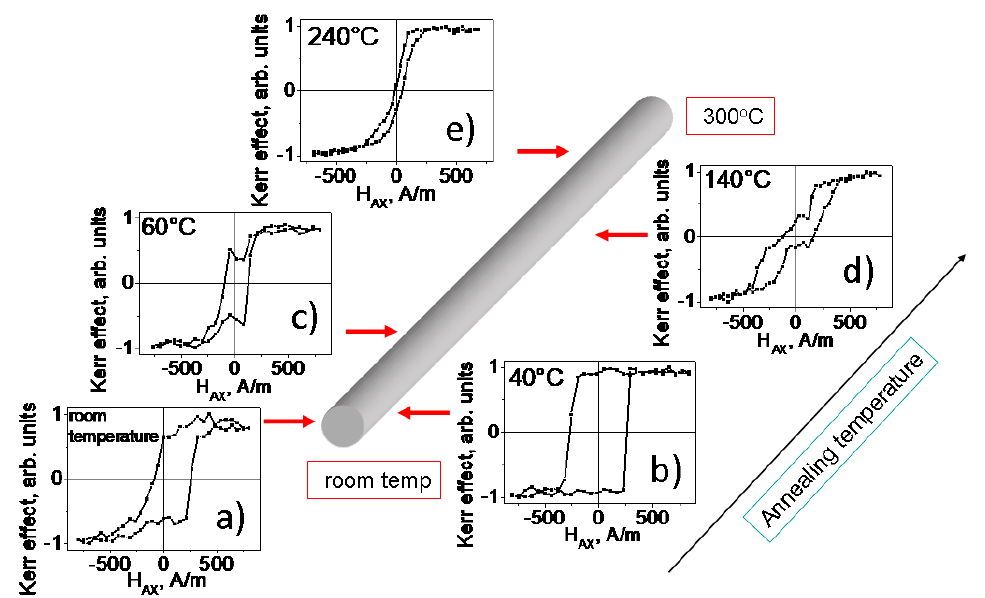
Figure 4. Distribution of MOKE hysteresis loops along the sample length. ( a ) room temperature, ( b ) 40 °C, ( c ) 60 °C, ( d ) 140 °C, ( e ) 240 °C.